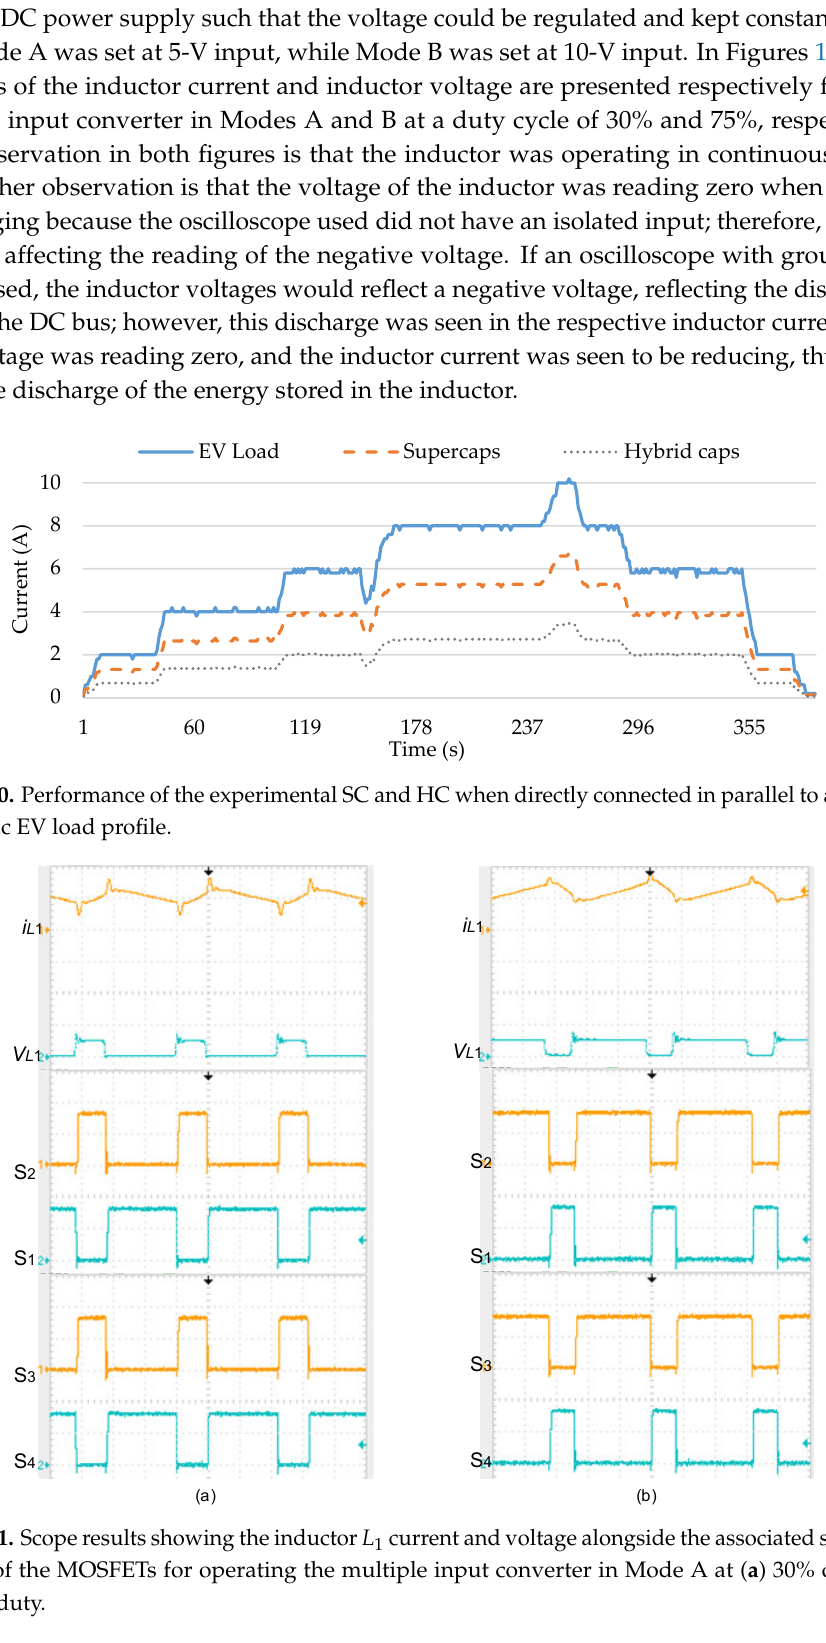
Figure 9. The experimental transient response of the SC bank, HC bank, and parallel arrangement of the SC and HC bank to a constant load current of 4.5 A rising to a pulse of 10 A with a rise time of 1 µs.